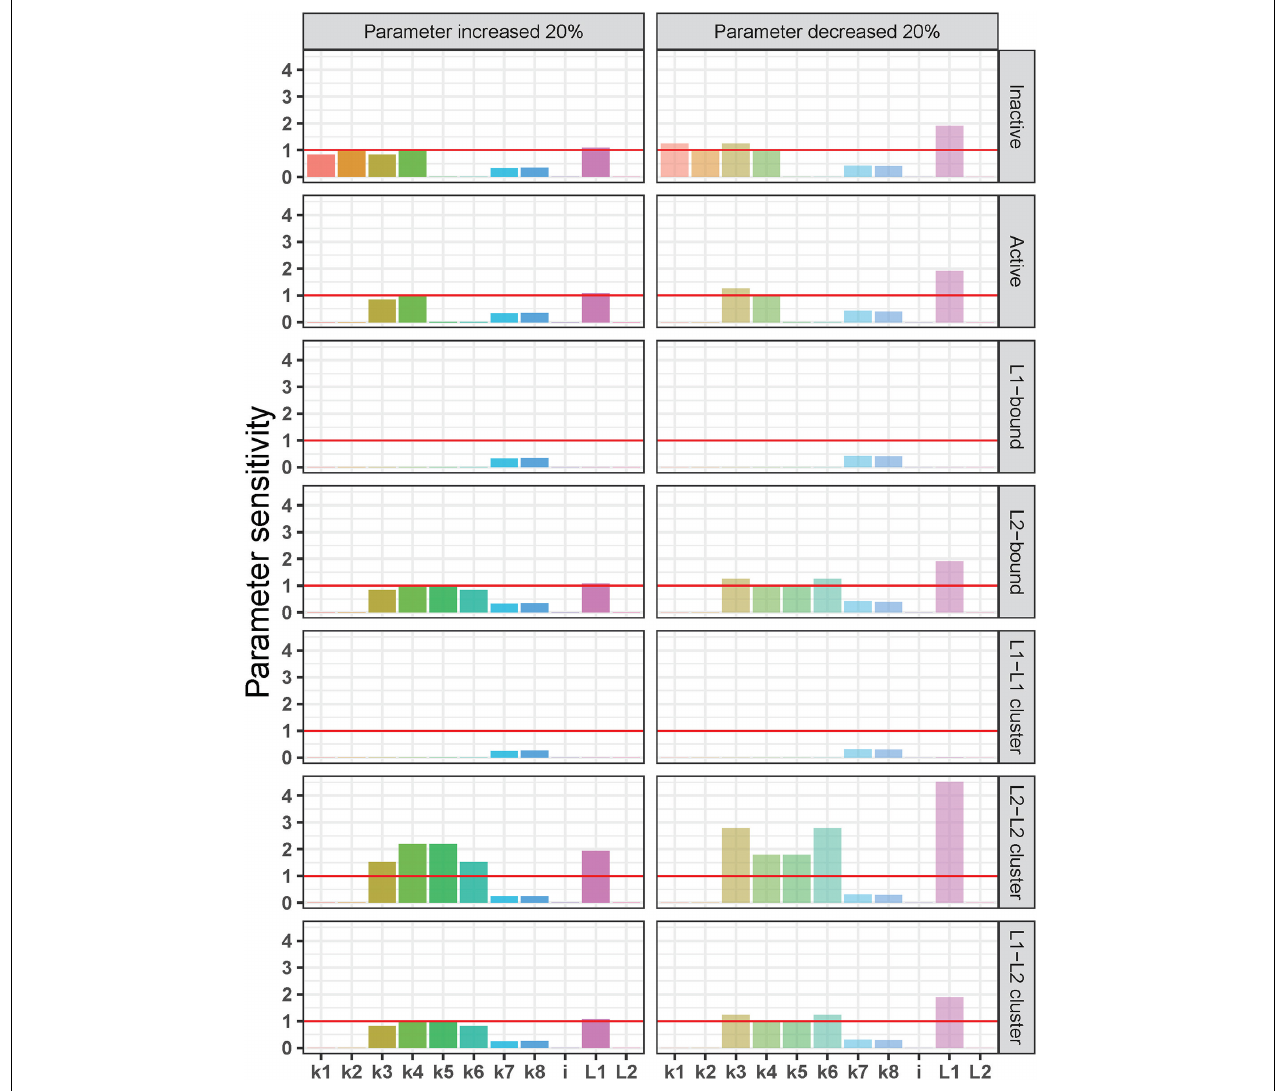
FIGURE 6 | Local sensitivity analysis of the integrin ligand competition model. Parameter sensitivity values on the y -axis indicate how a 20% increase (left) or decrease (right) in each parameter [rate constants for integrin activation-inactivation ( k 1– k 2), L 1 binding-unbinding ( k 3– k 4), L 2 binding unbinding ( k 5– k 6), integrin cluster formation-dissociation ( k 7– k 8), and initial concentrations of integrins ( i ) and the two ligands ( L 1 and L 2)] affects the steady state of each molecular species in the model (from top to bottom: inactive and active integrins, L 1-bound integrins, L 2-bound integrins, L 1- L 1-, L 2– L 2-, and L 1– L 2-bound integrin clusters). Parameter sensitivity of > 1 (red horizontal lines) indicates that the steady state of a molecular species is highly dependent on changes in parameter values, and values < 1 indicates a lower sensitivity to changes in parameter